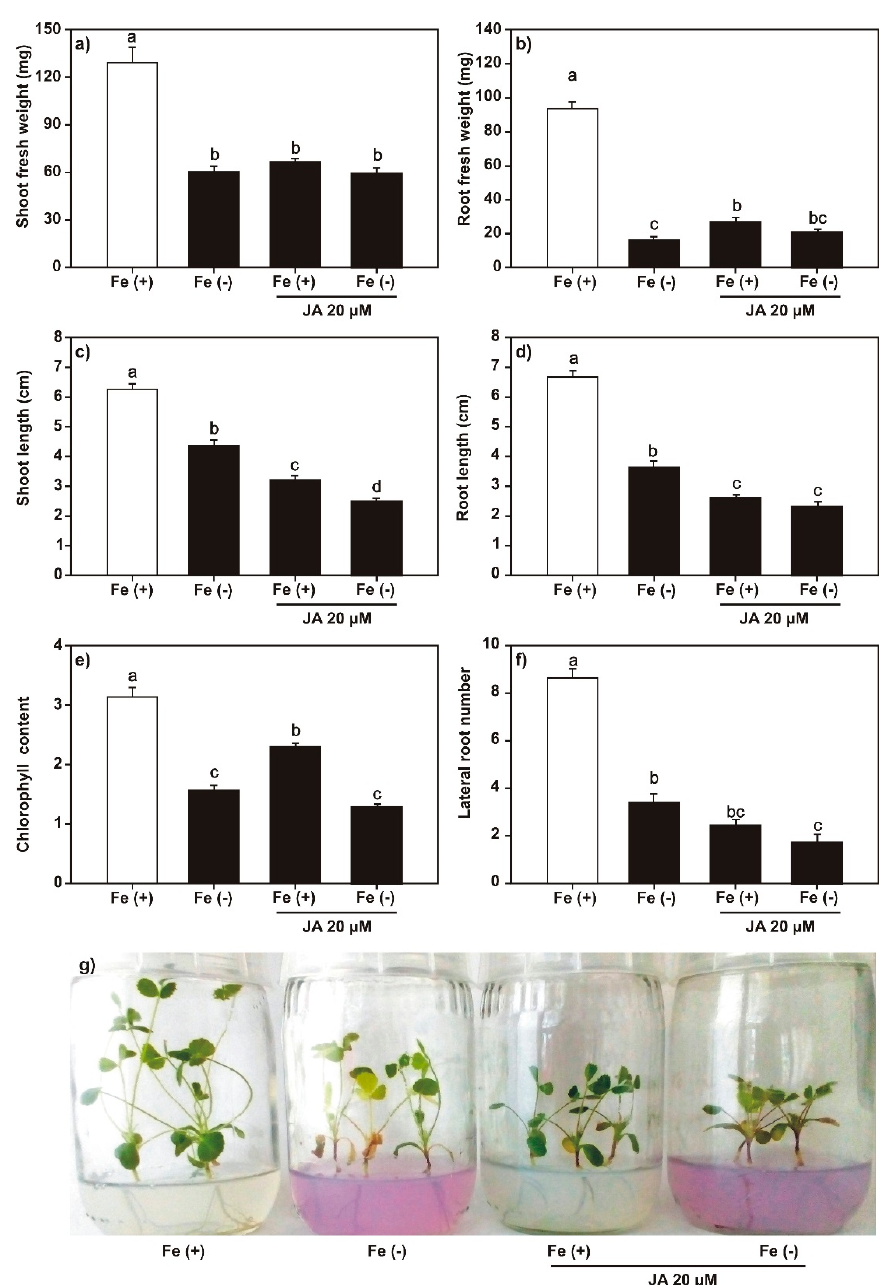
Figure 3. Effect of jasmonic acid (JA) on Medicago truncatula growth. The M. truncatula plants were cultured in MS medium with JA (20 μ M) under both iron sufficiency (control) and iron deficiency or 14 days. ( a ) Shoot fresh weight; ( b ) root fresh weight; ( c ) shoot length; ( d ) root length; ( e ) chlorophyll content; and ( f ) lateral root number. Panel ( g ) shows the phenotypes of plants in the treatments. Different lowercase letters above the standard error bars indicate significant differences between treatments calculated with two-way ANOVA and Tukey’s test ( p < 0.5; n = 9).